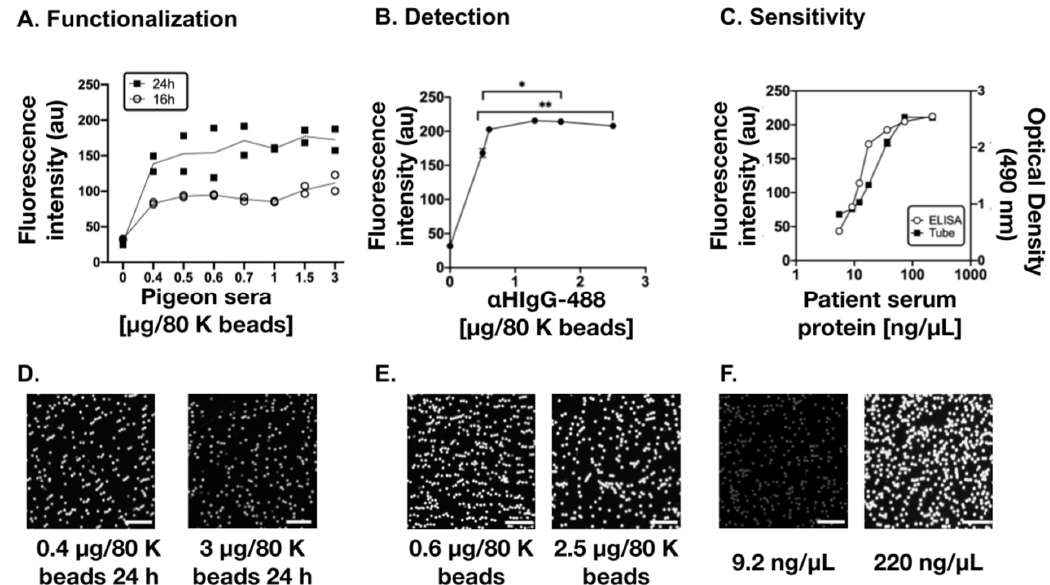
Figure 2. Optimization of the Diagnostic Biosensor Method. ( A ) Determination of pigeon serum (PS) concentration for functionalization and incubation time. Fluorescence intensity (au: arbitrary units) obtained with different concentrations of PS per sample (80 K beads) during 16 h (white dots) or 24 h (black squares) of functionalization incubation. ( B ) Determination of the optimal concentration of the secondary antibody ( α HIgG-488) concentration, at which the fluorescence intensity saturates. Data are represented as mean ± SD of n = 4 experiment, p < 0.0001. ( C ) Comparison of the sensitivity range of the ELISA and magnetic beads methods. Data are represented as mean ± SD of n = 3 experiment, p < 0.0001. ( D – F ) Representative microscopy images of ( A – C ), respectively. Scales: 50 µ m. Reaction platforms were 1.5mL low binding